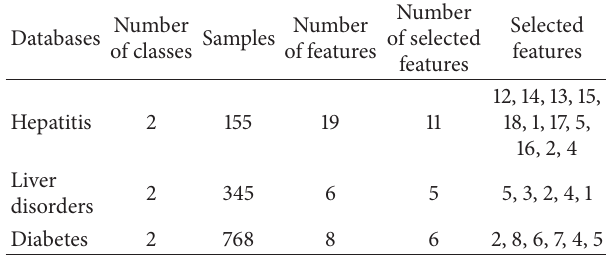
Table 5: List of datasets.